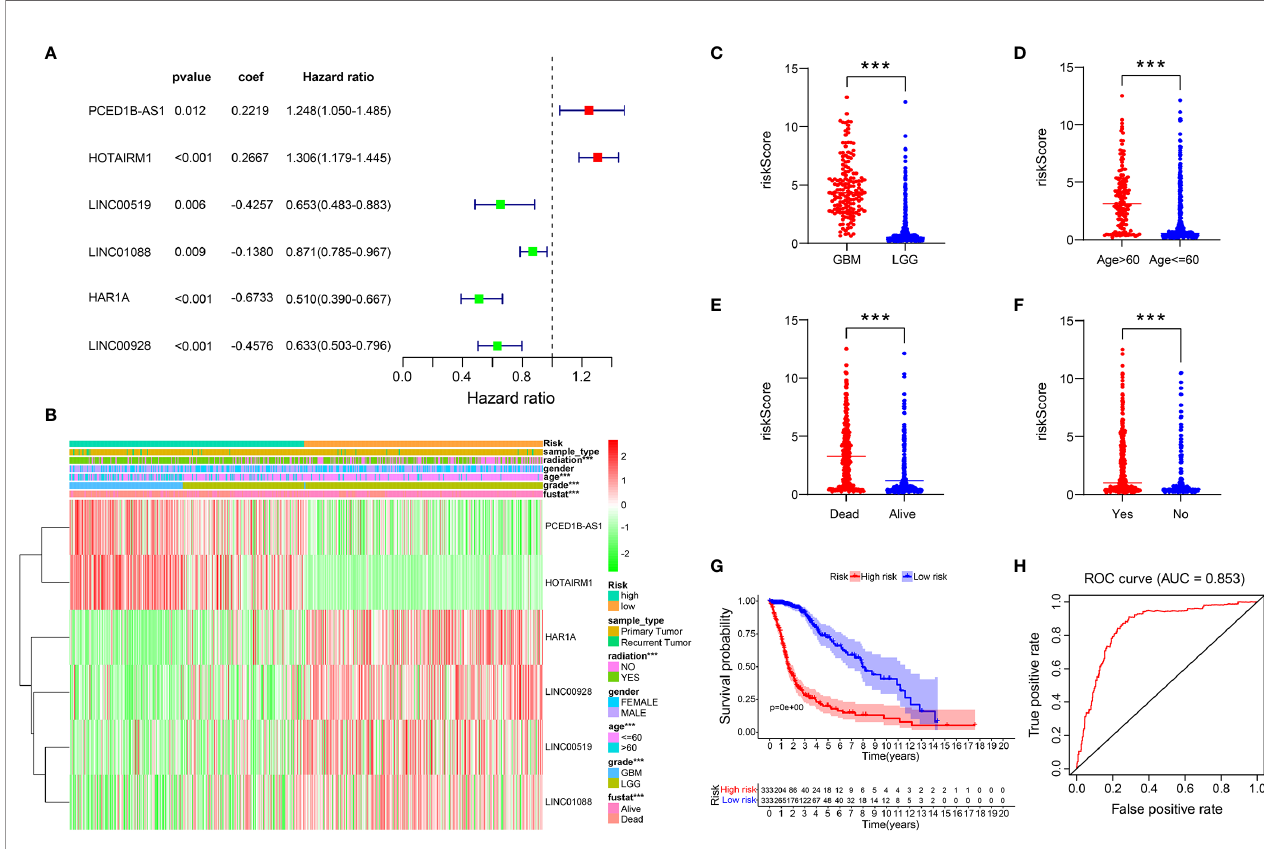
FIGURE 2 | A risk model with the 6 selected ER stress-related lncRNAs. (A) Multivariate Cox regression calculated the hazard ratio (HR) and regression coef fi cient of the six ER stress-related lncRNAs. (B-F) Differences in risk scores and clinicopathological features between two risk groups. (G) The K-M curves of two risk groups in training cohort. (H) ROC curve indicates the sensitivity and speci fi city of predicting the OS of patients in the training